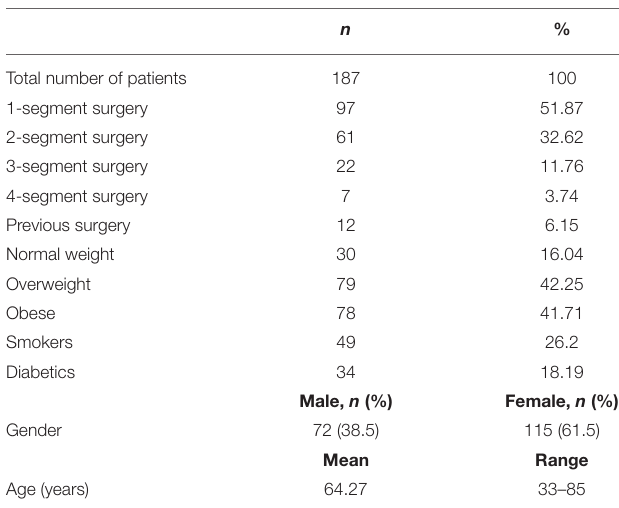
TABLE 1 | Baseline patient